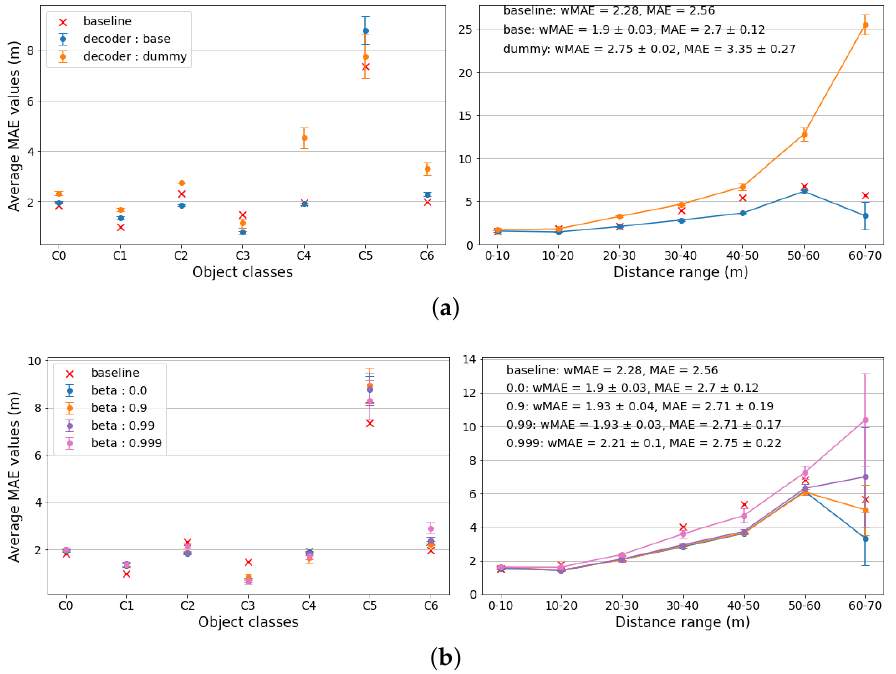
Figure 4. Experimental results for different CDR model settings (continuation). Here ( a ) shows the impact of the decoder function choice on the model’s performance, ( b ) – the impact of the β